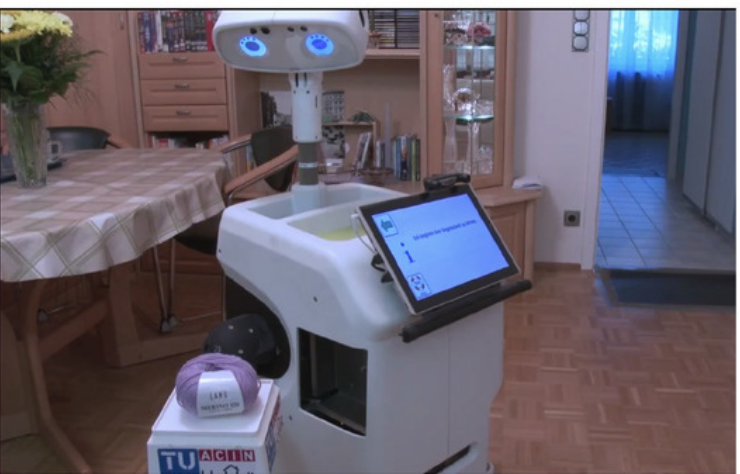
Figure 7. The Hobbit robot